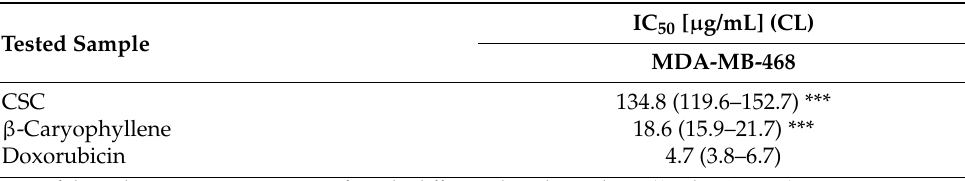
Table 3. IC 50 values of β -caryophyllene, cigarette smoke condensate (CSC) and the positive control doxorubicin in triple-negative breast cancer MDA-MB-468 cells. Data represent the mean ± SE of at least three independent experiments with at least three technical replicates ( n =